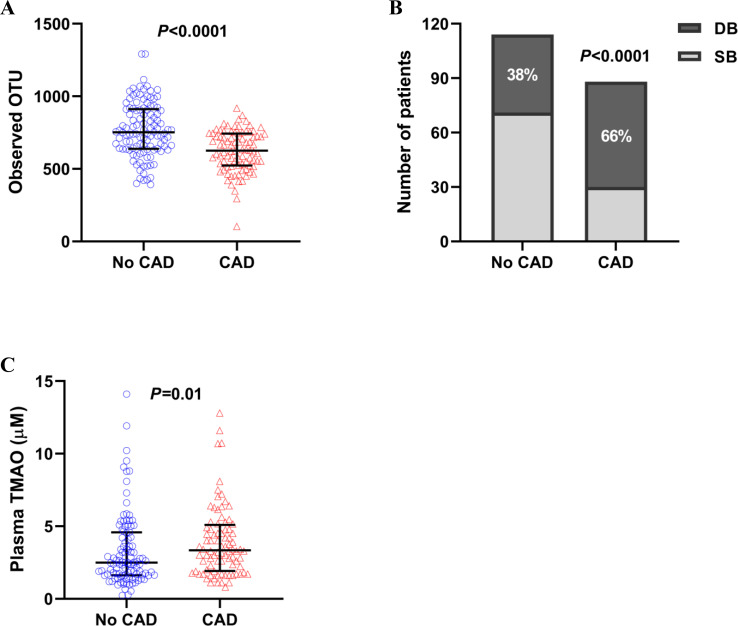
Comparison of gut microbiome composition, TMAO levels between patients with and without CAD.(A) Observed OTU was significantly lower in patients with CAD (N = 88) than those without CAD (N = 114) (Mann-Whitney U test P<0.0001). (B) The prevalence of dysbiosis was significantly higher in patients with CAD than those without CAD (58/88 [66%] vs. 43/114 [38%], χ2 test P<0.0001). (C) Plasma levels of TMAO were significantly higher in patients with CAD (N = 88) than those without CAD (N = 112) (Mann-Whitney U test P = 0.01). CAD, coronary artery disease; DB, dysbiosis; OTU, operational taxonomy unit; SB, symbiosis; TMAO, trimethylamine N-oxide.